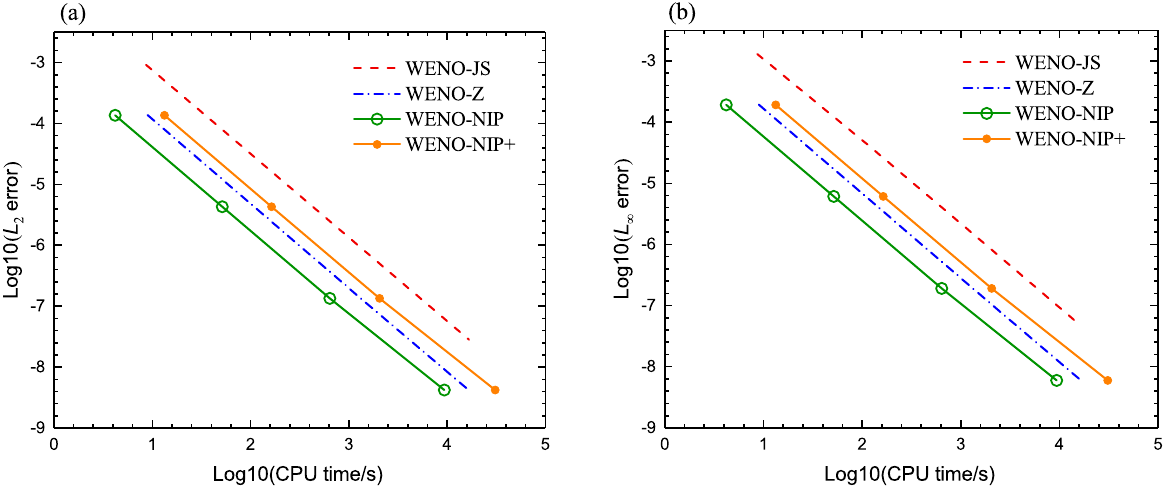
Figure 12. Comparison of various WENO schemes for Example 4 in CPU time and computing errors: ( a ) L 2 -norm error; ( b ) L ∞ -norm